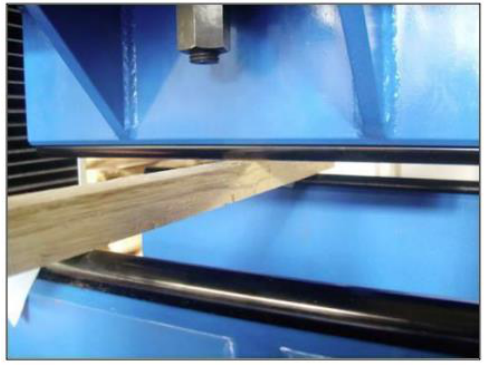
Figure 1. A detail of the Bending test setup ISO 13061-3.